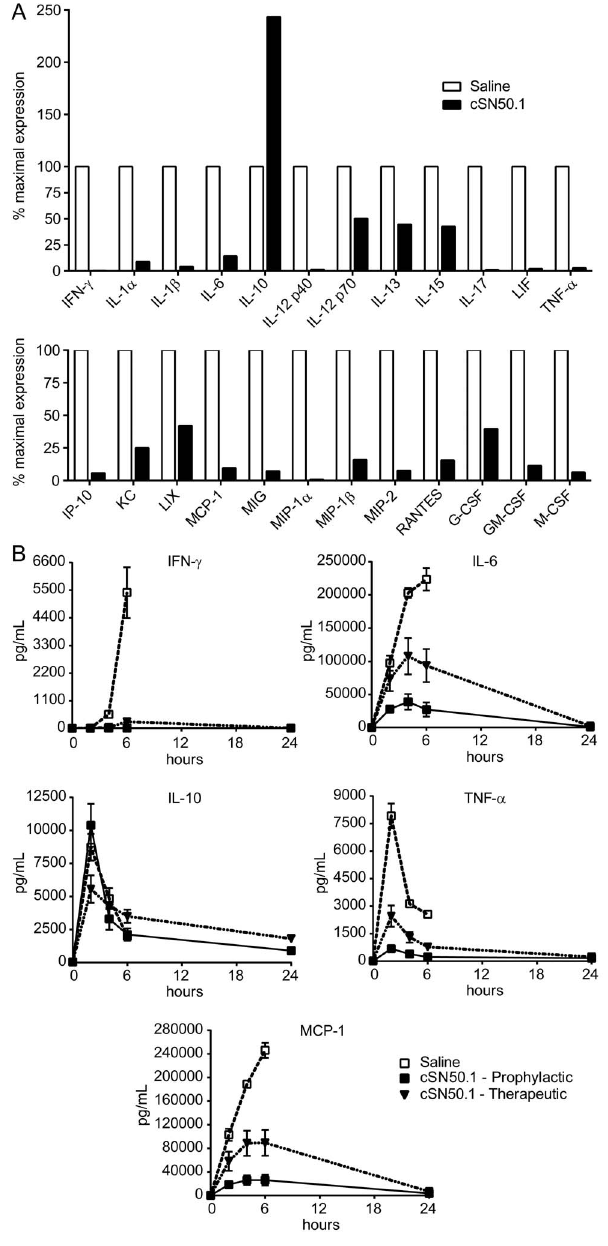
Figure 3. NTM treatment reduces plasma levels of multiple cytokines, chemokines and growth factors induced by LPS. (A) Wild type C57BL/6 mice were challenged i.p. with a lethal dose of LPS (800 m g) and treated with i.p. injections of NTM (cSN50.1 peptide) or diluent (saline) following a prophylactic protocol as in Figure 4A. Blood was collected at baseline and 2 or 6 h after LPS challenge and a multiplex assay was used to measure 32 analytes in plasma. Twenty- four analytes were significantly altered by NTM treatment, as determined by repeated measures two-way analysis of variance with Sidak’s post-test. Twenty-three were reduced, while anti-inflammatory IL-10 was increased by NTM treatment. Results are shown as the % inhibition or increase by NTM compared to saline control set to 100% at the time point demonstrating maximal expression for that analyte. n =10 animals/group. (B) Comparison of prophylactic and therapeutic NTM treatment protocols on selected plasma cytokine and chemokine levels in the high-dose LPS model of endotoxic shock. Data are presented as mean 6 standard error, n =5 2 10 animals/group.